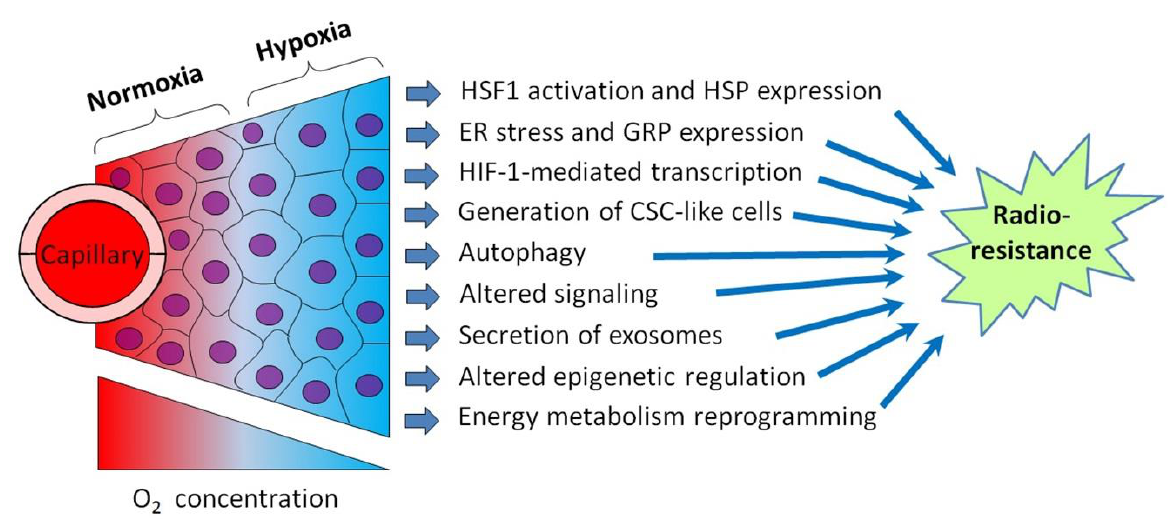
Figure 1. Schematic illustration showing intratumoral hypoxia and major hypoxia-induced cancer cell responses pro- moting the radioresistance of hypoxic tumors. Abbreviations: HSF1—heat shock factor 1, HSP—heat shock protein, ER—endoplasmic reticulum, GRP—glucose-regulated protein, HIF-1—hypoxia-inducible factor-1 and CSC—cancer stem cell. Tumor hypoxia is usually the result of several factors besides the radial gradient of the oxygen (O 2 ) concentration (see [6,7] for a review).